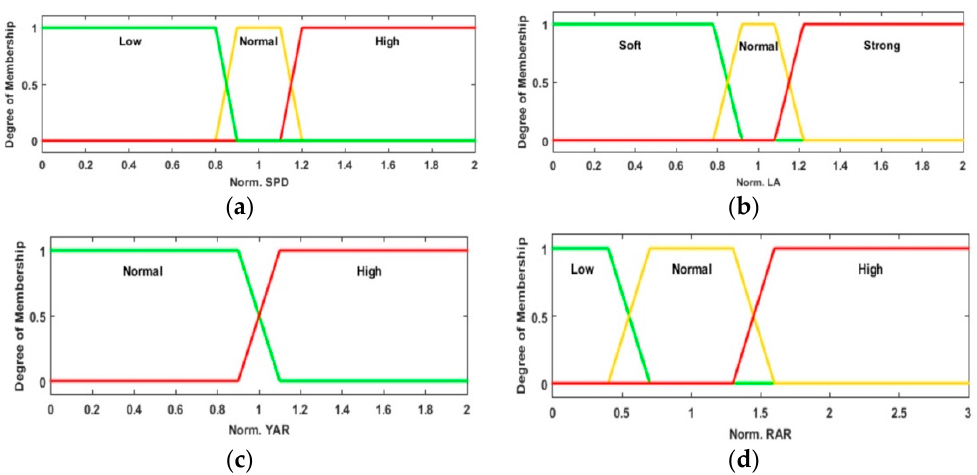
Figure 4. Proposed input variables membership functions: ( a ) Normalized Speed ( SPD Norm ), ( b ) Normalized Long. Acceleration ( LA Norm ), ( c ) Normalized Yaw Angle Rate ( YAR Norm ) and ( d ) Normalized Road Accident Risk ( RAR Norm ).